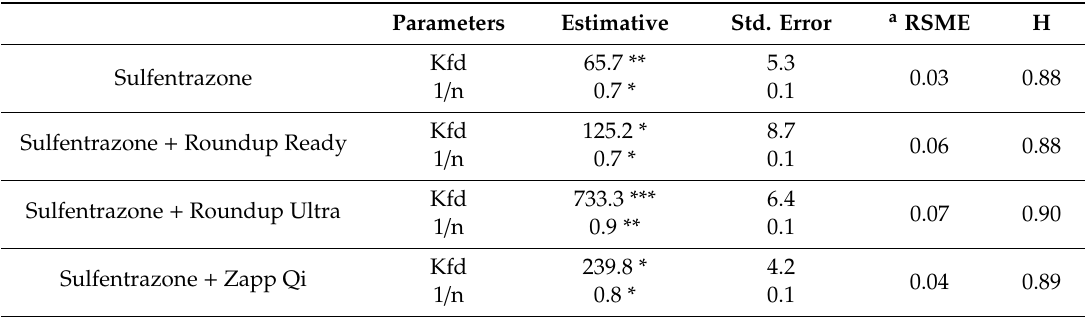
Table 5. Parameters of the desorption isotherms and hysteresis index (H) for sulfentrazone in isolation and mixed with glyphosate